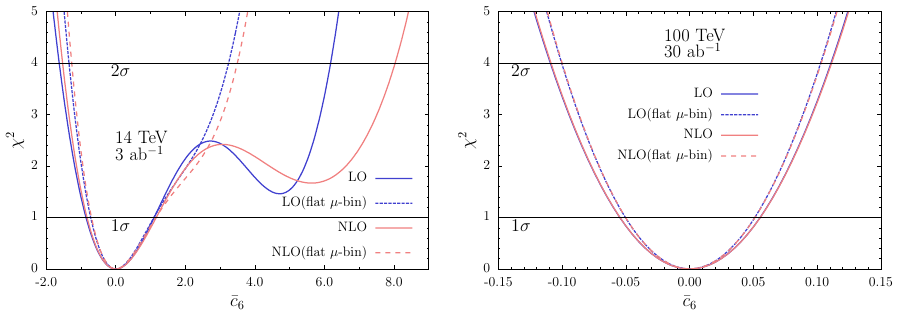
Figure 10 . (cid:31) 2 as a function of (cid:22) c 6 for (cid:22) c 8 = 0 at 14 (left) and 100 (right)